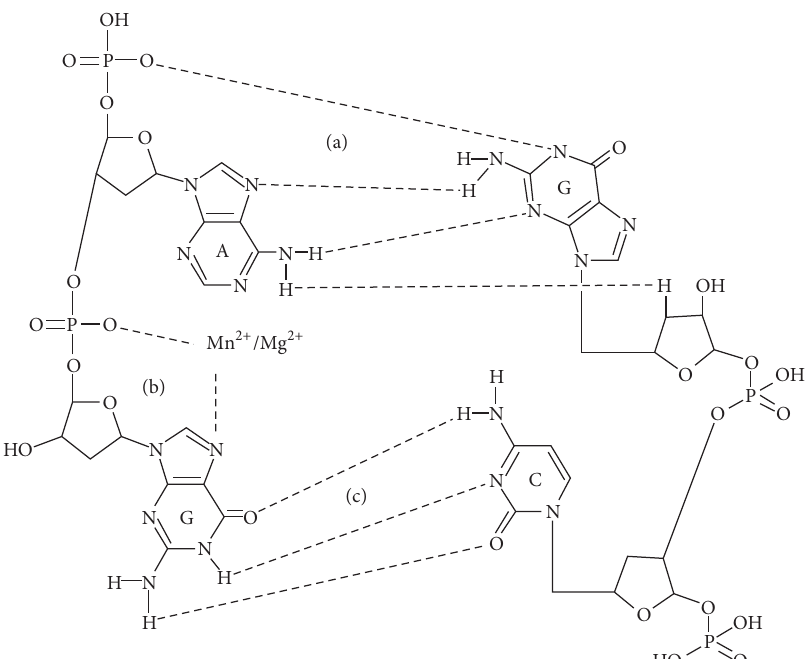
Figure 4: Binding site of Mn 2+ and Mg 2+ ions in RNA. Noncanonical (G ∙ A) ( 1 ) and canonical Watson-Crick (G:C) (c) binding of RNA nucleotides. Thermodynamic stability of G ∙ A and G:C (b) pairs is due to four and three hydrogen bonds, respectively. Hydrated ions of Mn 2+ or Mg 2+ (water molecules that are involved in coordination of RNA by metal ions are not depicted in the figure) coordinated the N7 level of guanine for the G:C pair and oxygen phosphoric acid residue of the adjacent phosphodiester bond; Mn 2+ has a greater affinity to nucleophilic nitrogenous bases, and Mg 2+ tends to form a rigid bond of